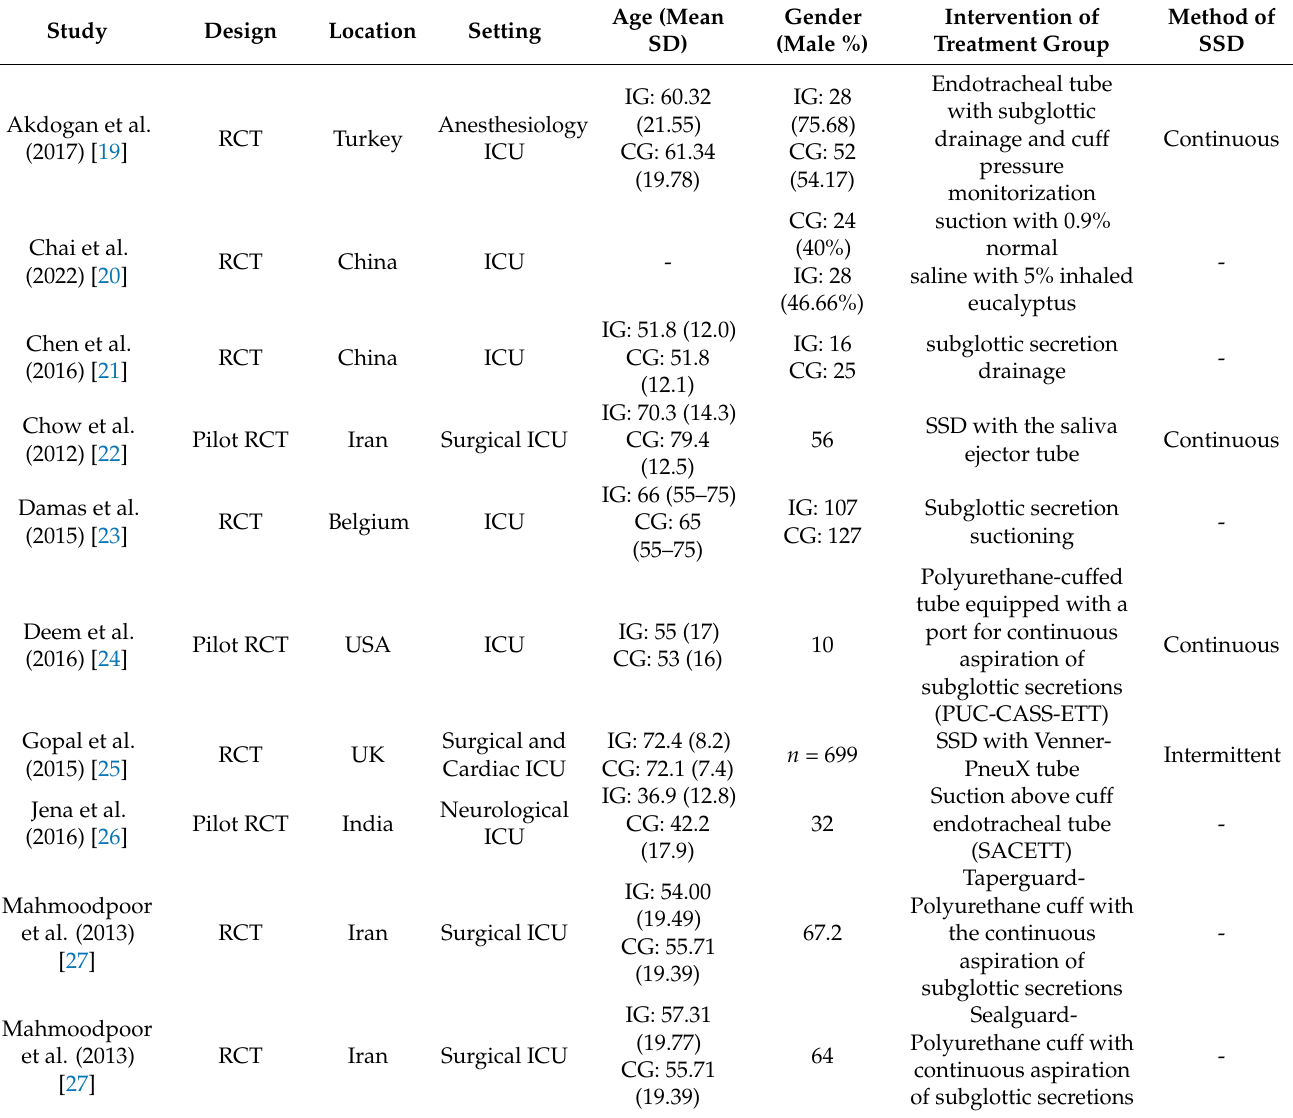
Table 1. Characteristics of included